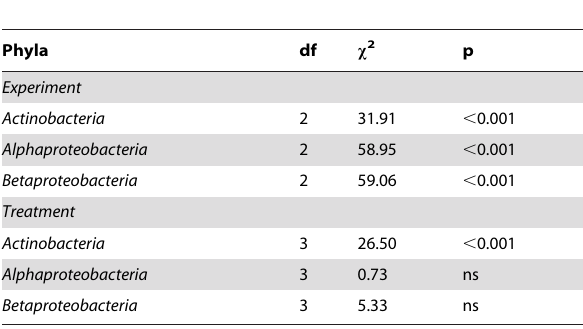
Table 4. Results from Kruskal-Wallis tests for experiment (seasonal) and treatment (nutrient addition) effects on the phylum distribution of Actinobacteria and Alpha- and Betaproteobacteria